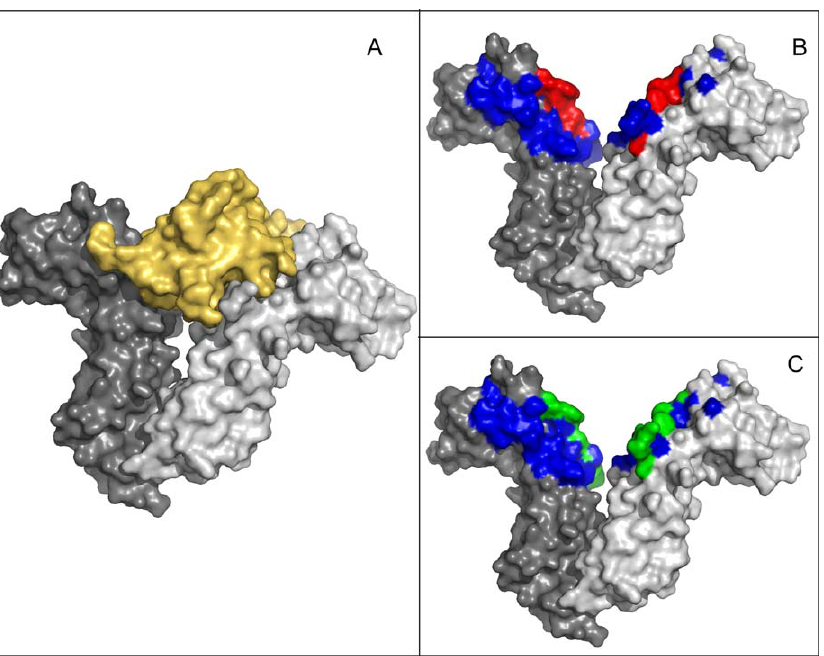
Figure 1. Protein–Protein Interfaces, Hotspots, and Predictions Residues that are part of protein–protein interfaces often constitute a large fraction of the protein. Hotspot residues, namely residues that upon mutation hamper the interaction, are only a small fraction of these interface residues. Interestingly, methods designed to predict interface residues usually capture only a small fraction of them. (A) Human growth hormone (yellow) bound to the extracellular portion of its homodimeric receptor. (B) The chains of the receptor (gray) are 201 residues long. The protein–protein interface covers 31 of these residues (blue and red) on each of the chains. Mutating one of the six residues colored in red abrogates or severely hampers the interaction. (C) A prediction method (ISIS; see text) that was designed to identify all interface residues managed to capture only five of the interface residues (colored